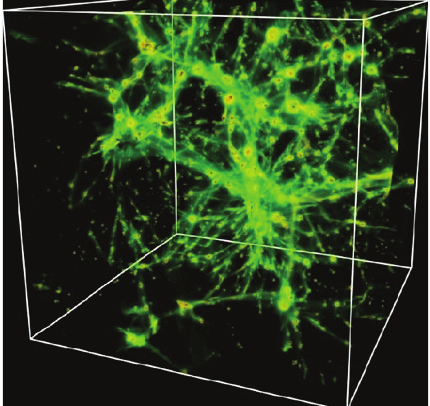
Figure 2: The spatial distribution of hot baryons in the model of Cen and Ostriker [9] and Dav´e et al.